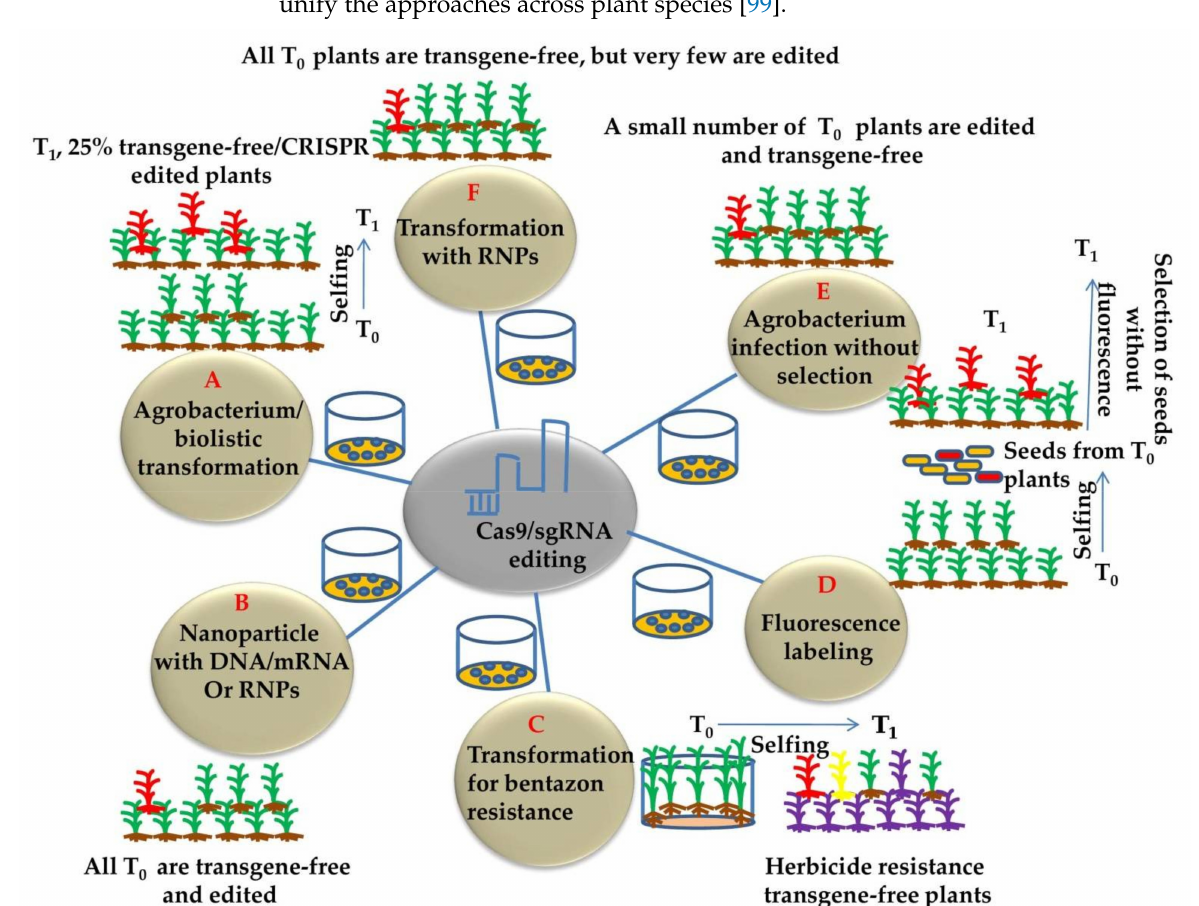
Figure 4. Commonly used approaches for developing transgene-free and CRISPR-edited plants ( A ) CRISPR gene editing followed by agrobacterium/biolistic transformation obtaining 25% T 0 transgene free plants by following Mendelian segregation. ( B ) Nanoparticle and RNP mediating gene editing. DNA, RNA, or RNP coated nanoparticles can deliver CRIPSR reagents into meristematic cells. This strategy typically produces mosaic plants. The transgene-free and edited plants may be obtained by either sexual or asexual propagation from the edited tissues. ( C ) Drug-induced elimination of transgenes. The CYP81A6 encodes an enzyme that metabolizes bentazon, which is a herbicide. Coupling CYP81A6 RNAi with CRISPR components enables a selection for transgene-free and edited plants. ( D ) Fluorescence labeling and selection of transgene free plants. The mCherry fluorescence marker is linked to the gene-editing components in the same plasmid. The marker allows for the selection of transgene-free seeds, greatly reducing the workload associated with growing plants and genotyping. ( E ) Generation of edited plants using transient expression under no selection pressure. In the absence of a selection pressure, Agrobacterium infection can lead to the expression of transgenes without integrating the transgenes into chromosomes. Such events can lead to the generation of transgene-free and edited plants. ( F ) Ribonucleoprotein or RNP (Nuclease and gRNA) method generating transgene free plants by particle bombardment/gene gun into calli or immature